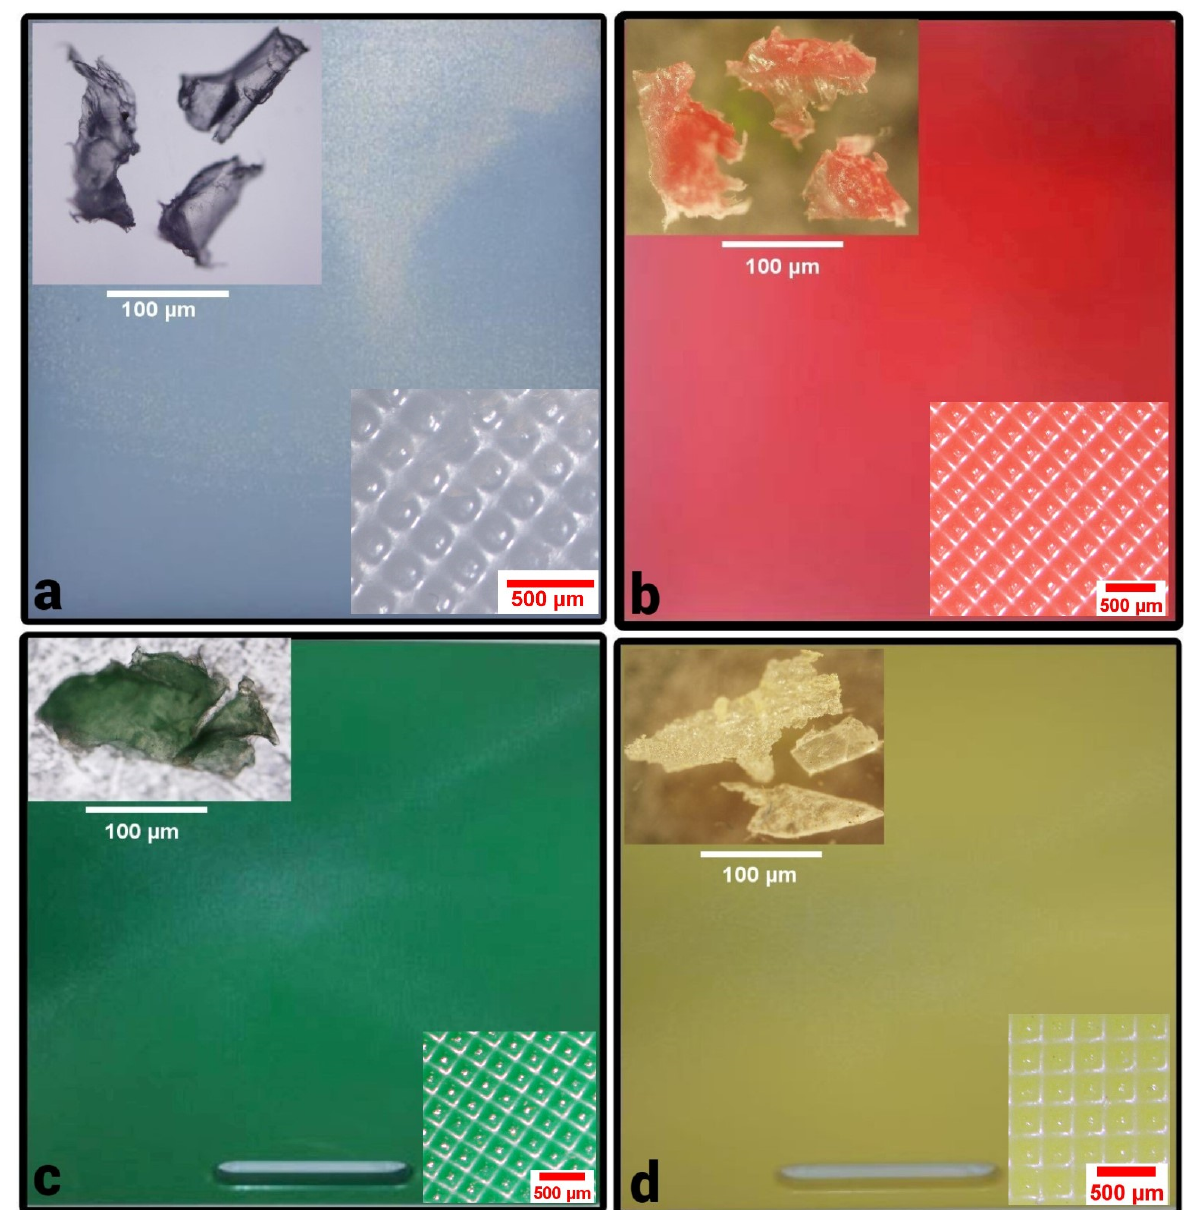
Figure 1. Examples of cutting boards used by markets with corresponding generated microplastic fragments (upper left corner, photos taken with microscope Olympus model BX41TF) and surface texture of the cutting boards (lower right corner, photos taken with stereoscope model SZ2-ILST): ( a ) CB-1 (white/colorless); CB-2 (red); CB-3 (green); CB-4 (yellow) where are ( b – d ).